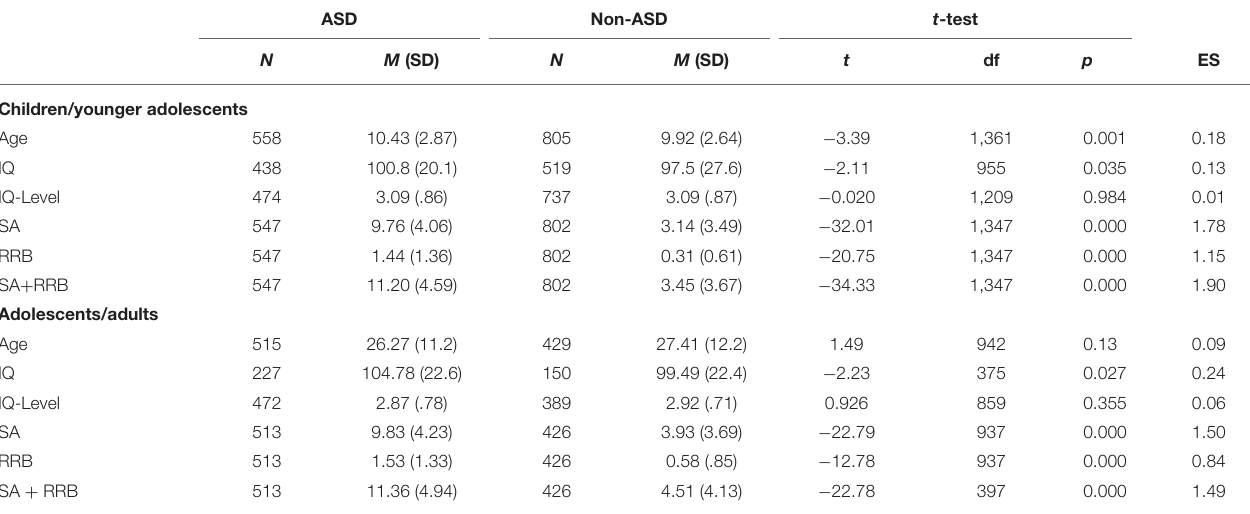
TABLE 1 | Sample characteristic for the two subsamples of children/younger adolescents (ADOS module 3 and associated ADI-R data) and adolescents/adults (ADOS module 4 and associated ADI-R data). ASD Non-ASD t -test N M (SD) N M